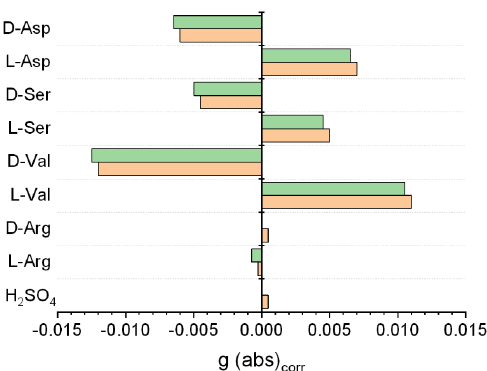
Figure 6. Bar graph of the relative values for the dissymmetry g -factor (orange bars) and the corrected values for the reference sample (green bars, see text) measured at the J-band for J-aggregates of TPPS 4 in the presence of the various enantiomeric pairs of amino acids investigated in this study.